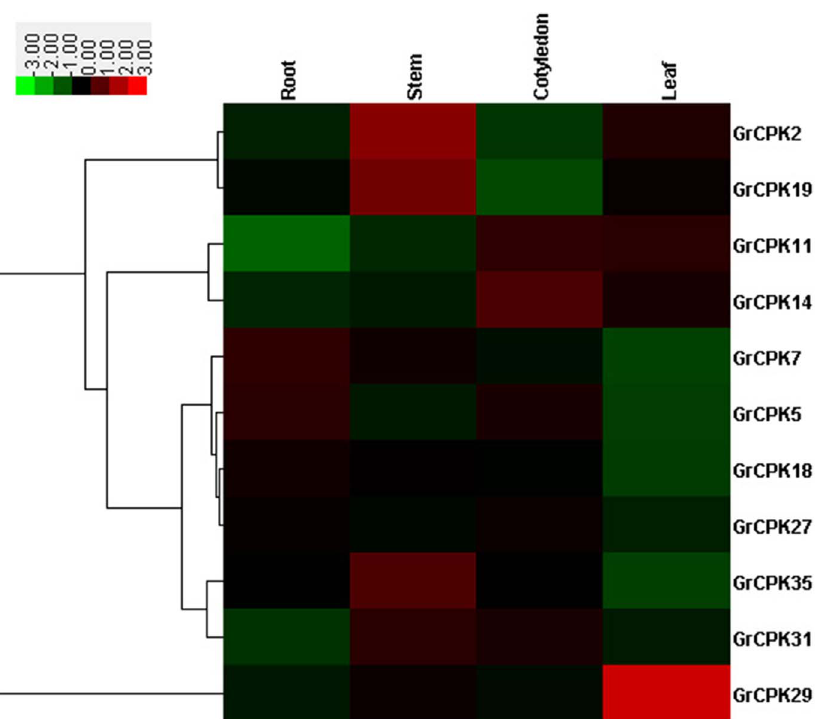
Figure 4. Expression patterns of 11 GrCPKs in four representative tissues of G.raimondii seedlings. The color bar represents the relative signal intensity